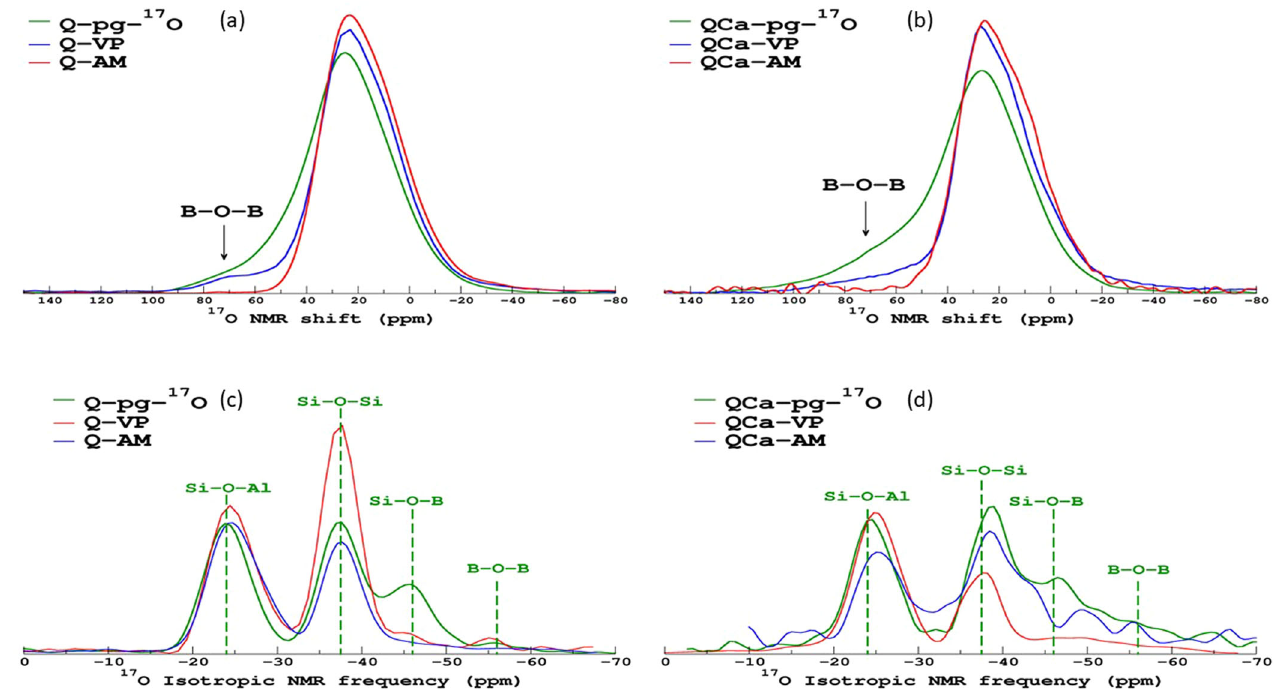
Fig. 5 17 O MAS NMR spectra. a , b The pristine samples enriched in 17 O (called pg- 17 O), samples altered in aqueous medium (called AM) and samples altered in vapor phase (called VP) of the a Q glass and the b QCa glass; c , d projections in the isotropic dimension of the 17 O MQMAS NMR spectra for the Q and the QCa samples respectively (pristine, altered in vapor phase and in aqueous